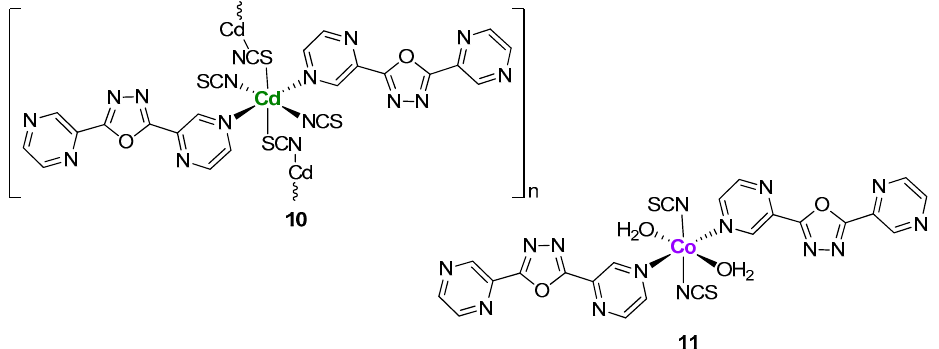
Figure 4. ( a ) Structures of the ligand 2,5-bis(pyrazine)-1,3,4-oxadiazole (Lc) and ( b ) its Ag(I) coordination polymer. Picture is adapted from reference [12] and was generated with Chimera software [17] using the original CIF data.